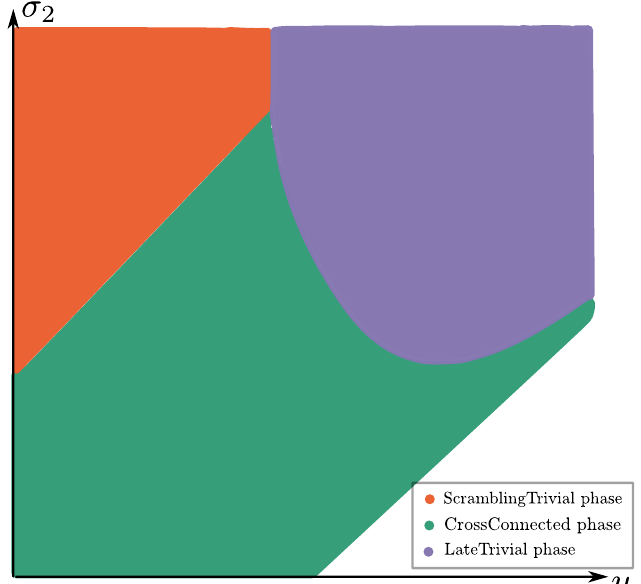
Figure 16. This figure is a phase diagram that shows the saddles that dominate the generalized entropy for each time and σ 2 in the region around the temporary blindness in the interior recon- struction window. We used T 0 = 453 , 5 for this plot. The values of the other parameters used, can 512 π be found in table